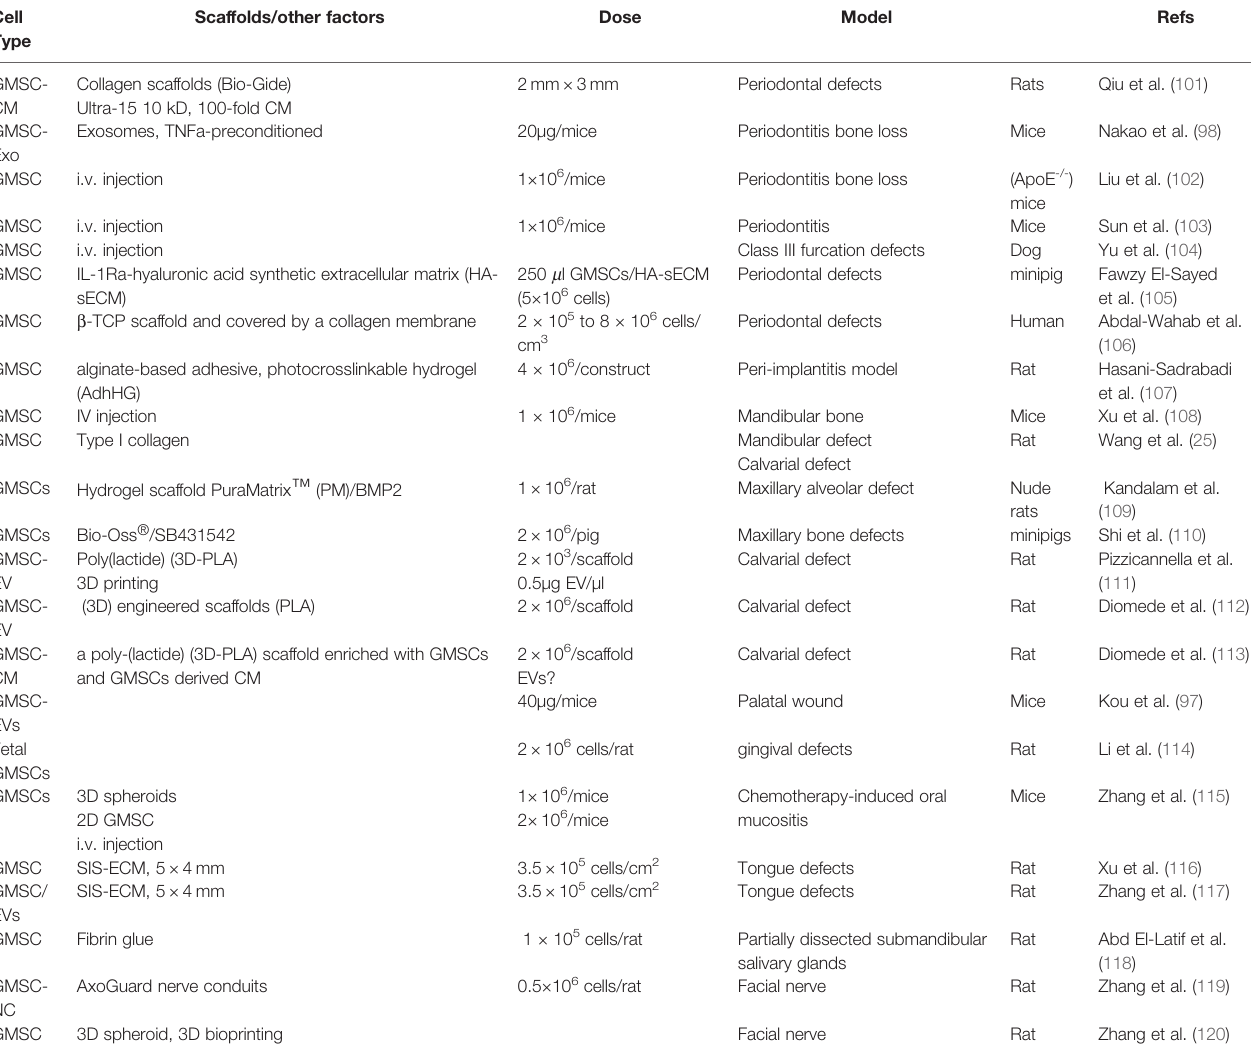
TABLE 5 | GMSC-based regenerative therapy in oral & craniofacial